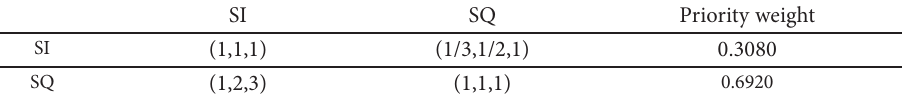
Table 7. Fuzzy evaluation of sub-factors as to perceived usefulness (PUS)